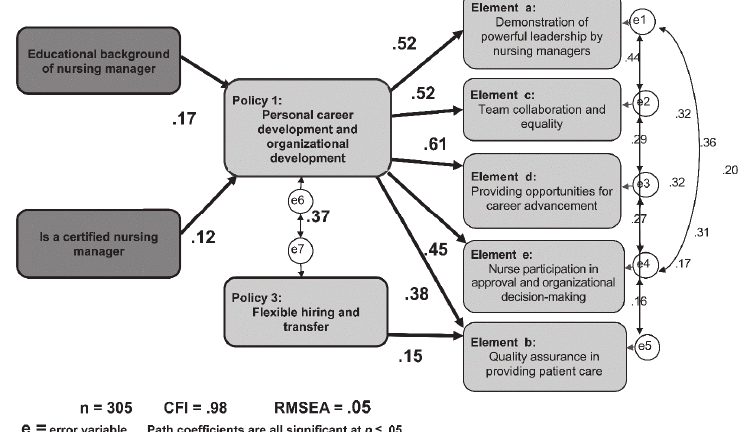
Fig. 3. Path model for attributes of nursing managers and elements of HRM, human resource man- agement policies, and PES-NWI. CFI = comparative fit index; HRM = human resource management; RMSEA = root mean square error of